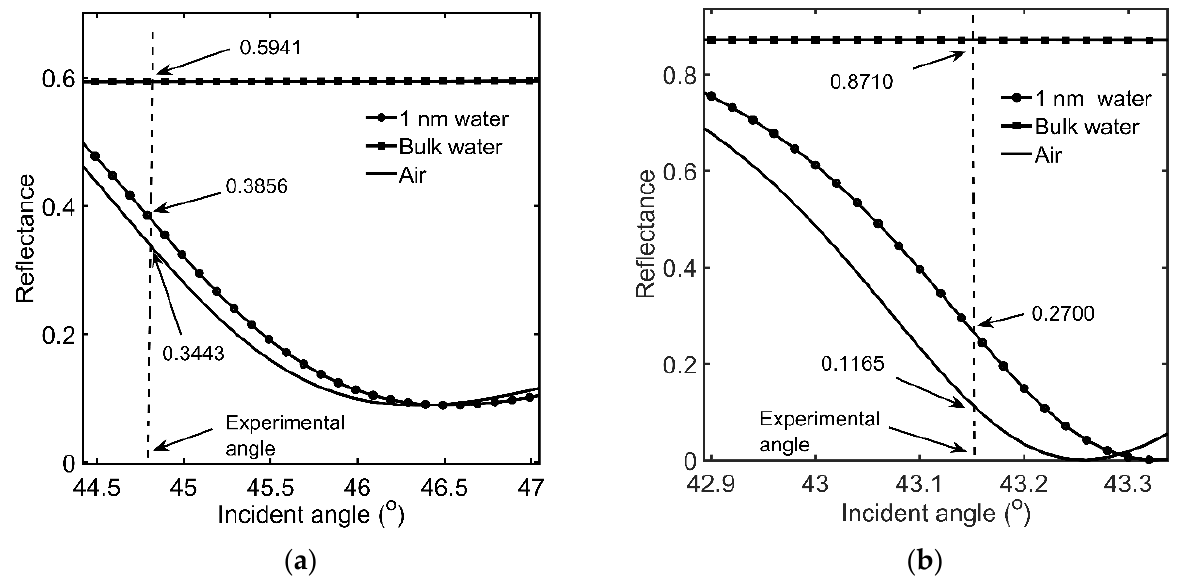
Figure 2. Theoretical SPR plots showing the effect of 1 nm water film on the reflectance at two wavelengths, ( a ) 550 nm and ( b ) 680 nm.